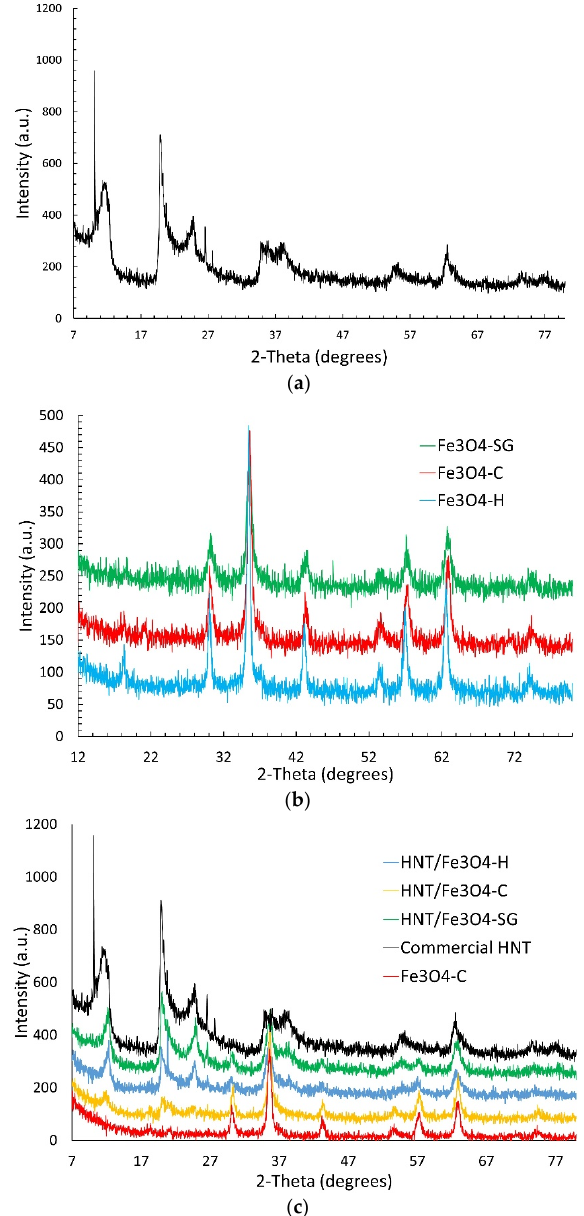
Figure 1. XRPD patterns of ( a ) commercial HNT, ( b ) Fe 3 O 4 , and ( c ) HNT/Fe 3 O 4 composites, Fe 3 O 4 and HNT.